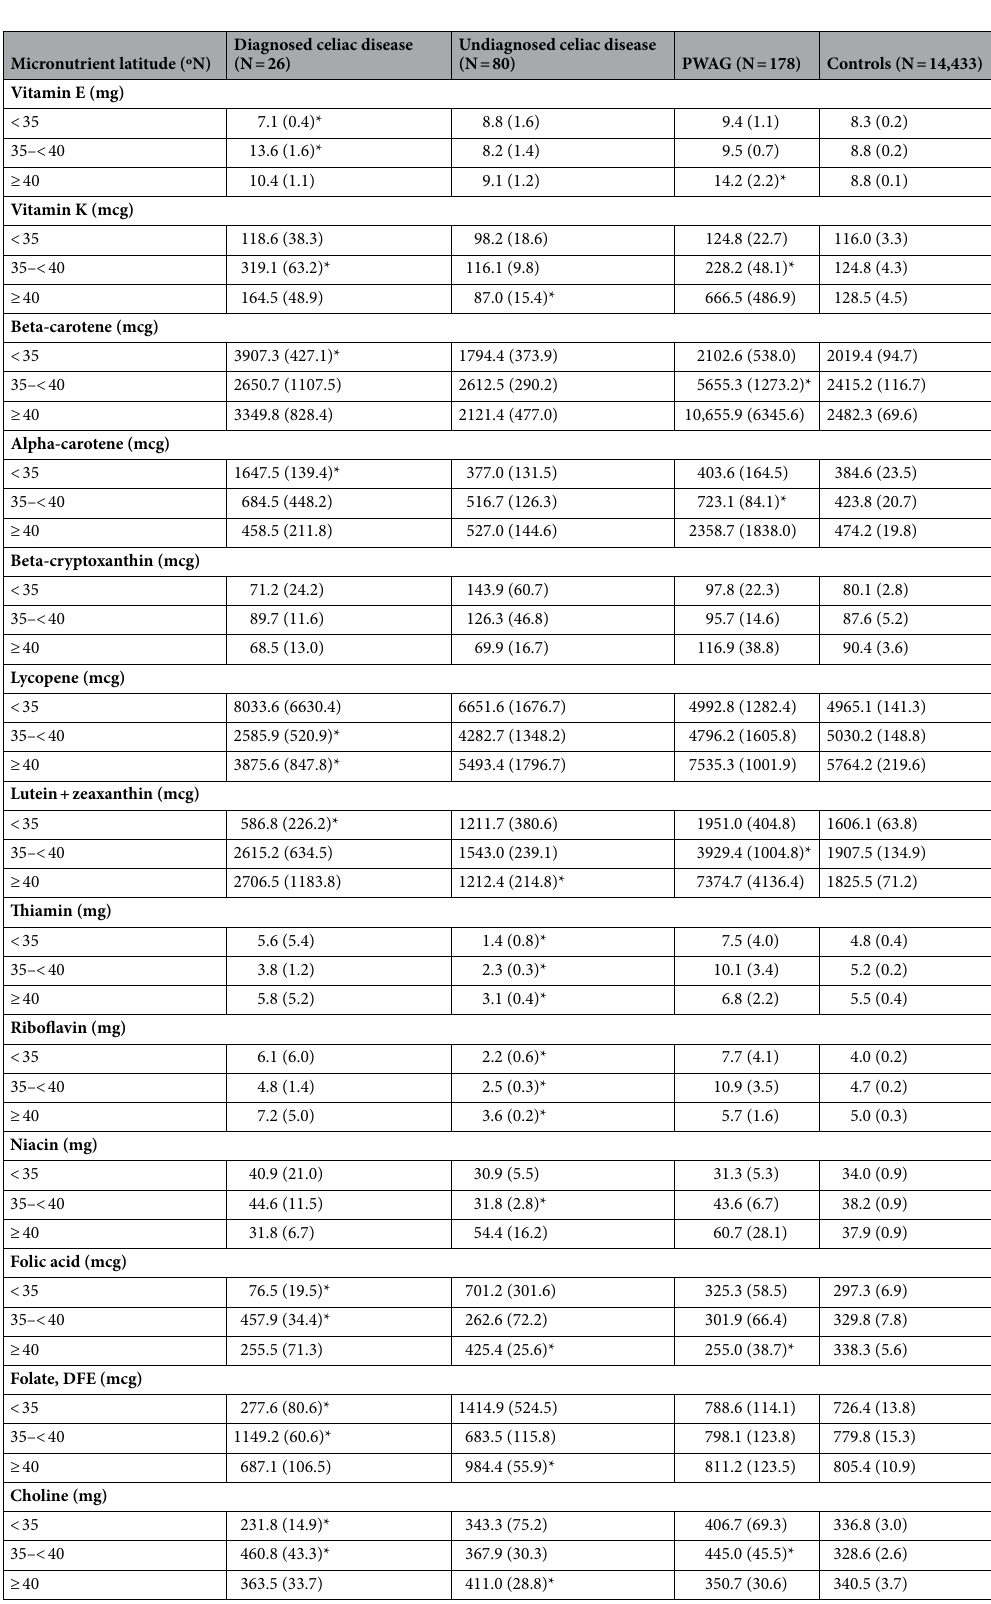
Table 5. Adjusted a mean (SE) total micronutrient intake from food and supplements among NHANES participants 20 years and older with and without celiac disease and PWAG by latitude, United States, 2009– 2014. NHANES, National Health and Nutrition Examination Survey; PWAG, persons without celiac disease avoiding gluten; SE, standard error. a Adjusted for age, sex and race/ethnicity. b Vitamin D2 + vitamin D3. * p < 0.05 compared with